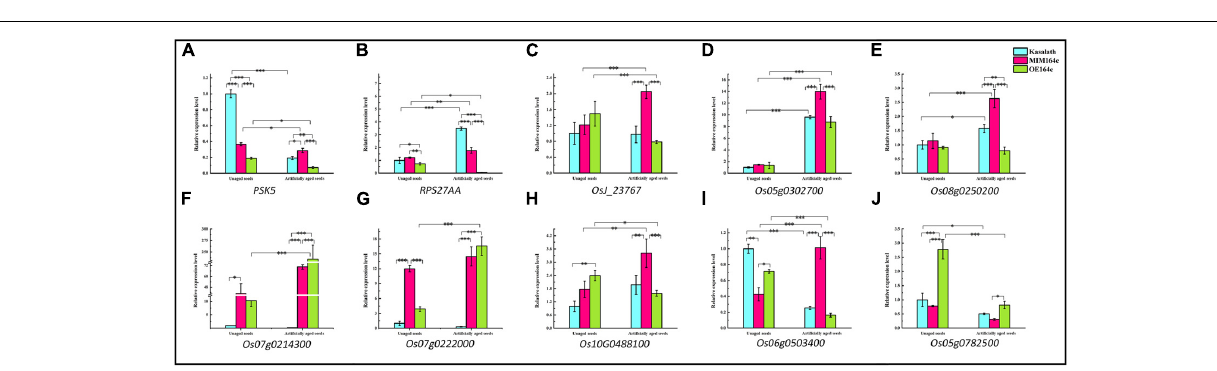
FIGURE 12 | RT-qPCR assay of the expression level of 10 genes in WT, ST, and OT seeds before and after artificial aging. (A–C,H) Core genes in the interaction network in Figure 9 . (C–E) Genes related to energy metabolism. (F,G) Genes corresponding to serine-type endopeptidase inhibitors. (H–J) Stress-related genes. Data represent mean ± SD ( n = 3). Significant differences in gene expression levels among the three rice genotypes were determined by Tukey’s test ( ∗ P < 0.05, ∗∗ P < 0.01, ∗∗∗ P < 0.001). The expression level of each gene in unaged WT seeds was defined as